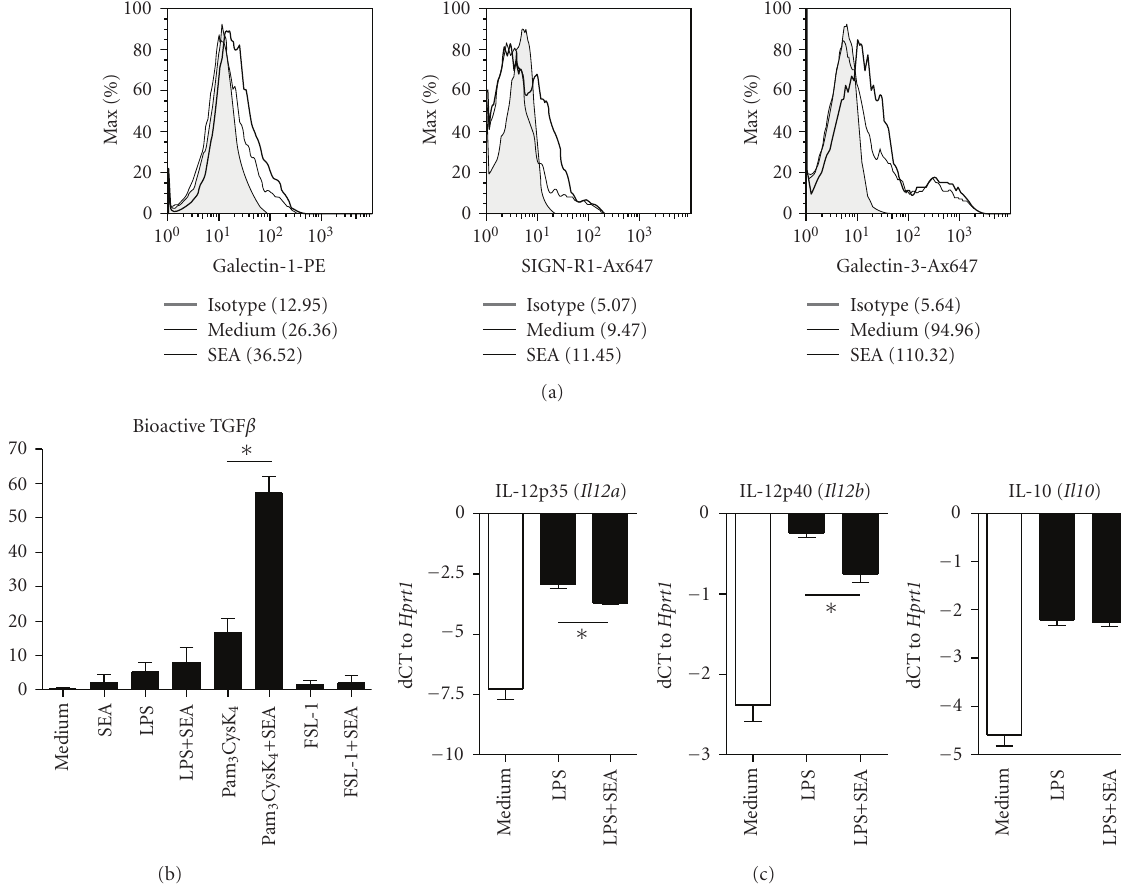
Figure 1: Schistosome soluble antigens change the phenotype of primary splenic DCs. (a) DCs, isolated by immunomagnetic selection, increase surface expression of CLRs in response to SEA stimulation. DCs were cultured overnight with 25 μ g/ml SEA and were analyzed by flow cytometry, excluding nonviable (7-AAD + ) cells. Data are representative of at least three independent experiments. (b) SEA enhances bioactive TGF β production by DCs stimulated with Pam 3 CysK 4 . DCs were isolated by immunomagnetic selection and cultured for 48 hours at 1 × 10 5 /well with 100 ng/ml LPS, 100ng/ml Pam 3 CysK 4 , and/or 25 μ g/ml SEA. The supernatants were then cultured with a TGF β - responsive cell line and compared to a dose-response curve for recombinant human TGF β 1. Data shown are the means +/ − SEM of triplicate wells. (c) SEA decreases LPS-induced IL-12p35 and p40 mRNA levels in splenic DCs. Cells (5 × 10 5 ) were stimulated for 4 hours in the presence of 100 ng/ml LPS and/or 25 μ g/ml SEA, and mRNA was analyzed in real time using qPCR. Data shown are the means +/ − SEM of data from three experiments. ∗ P < . 05 by paired t test, two